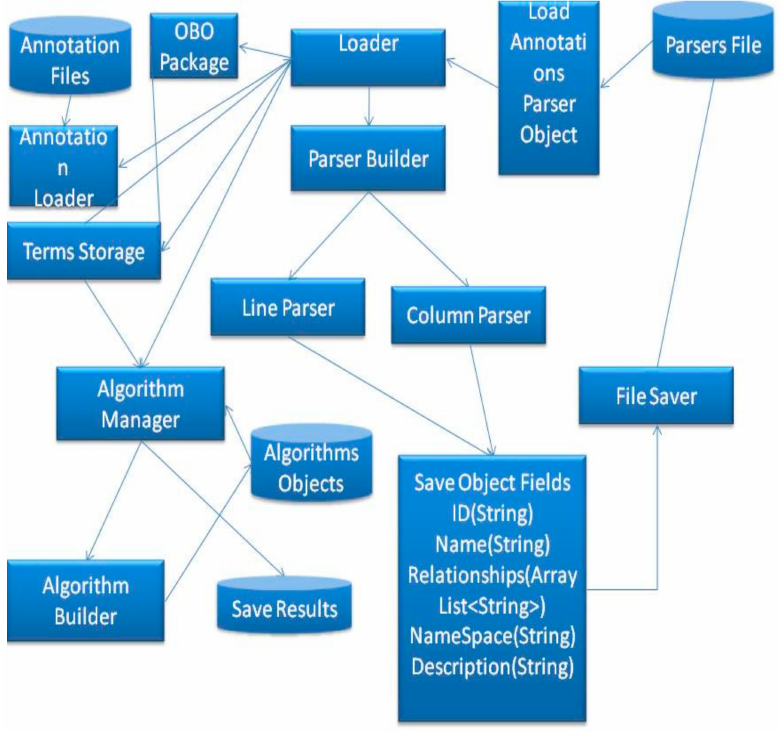
Figure 8. Implementation